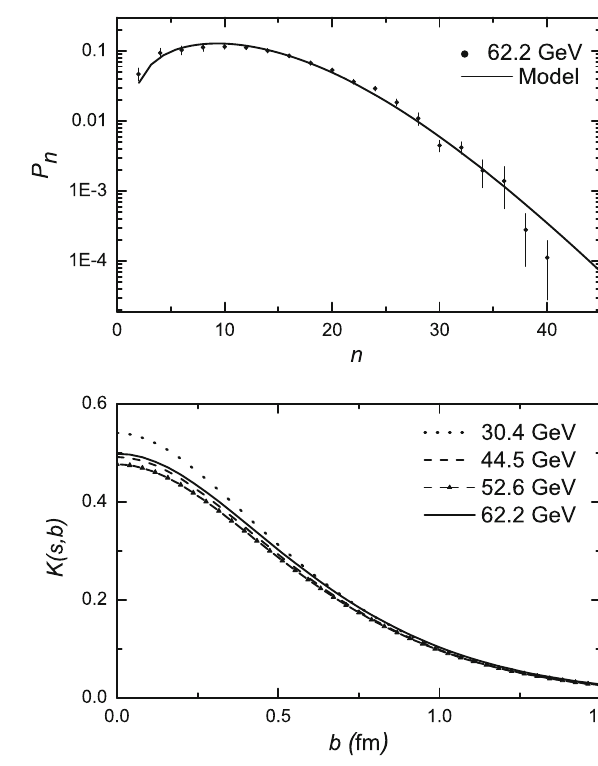
Fig. 2 Same as Fig. 1 but at 44.5 GeV